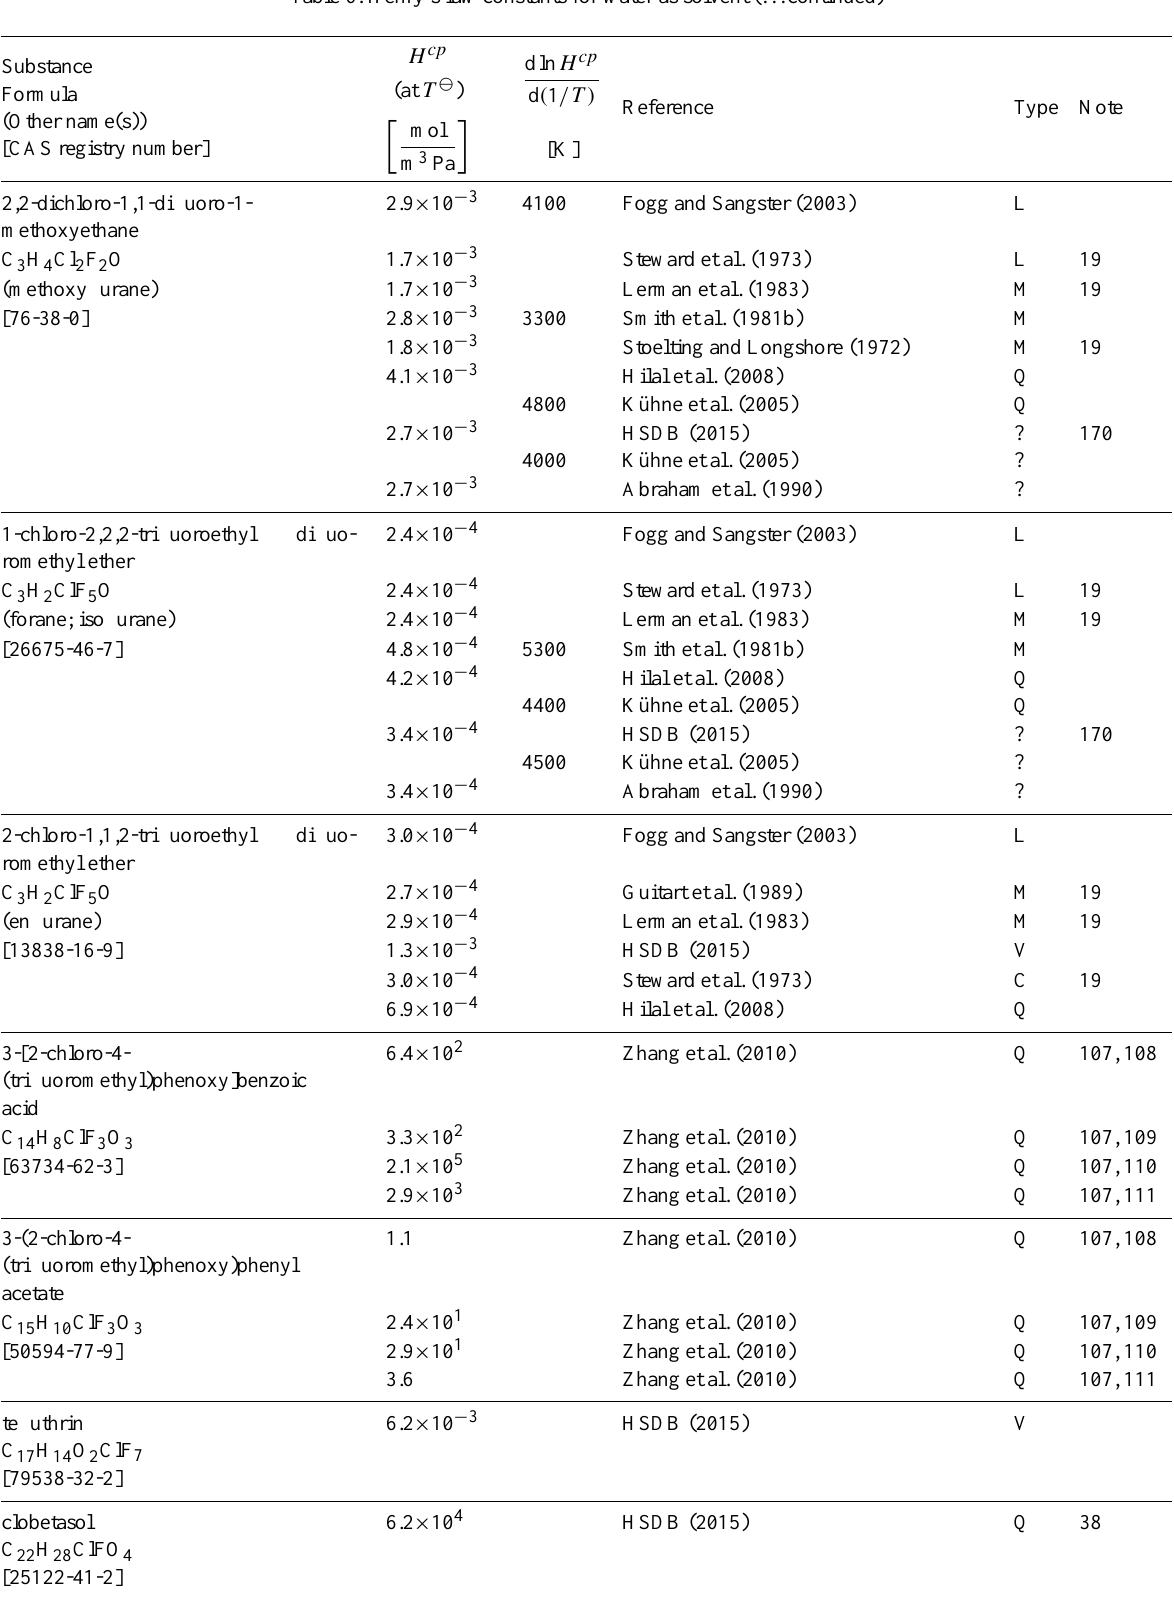
Table 6: Henry’s law constants for water as solvent